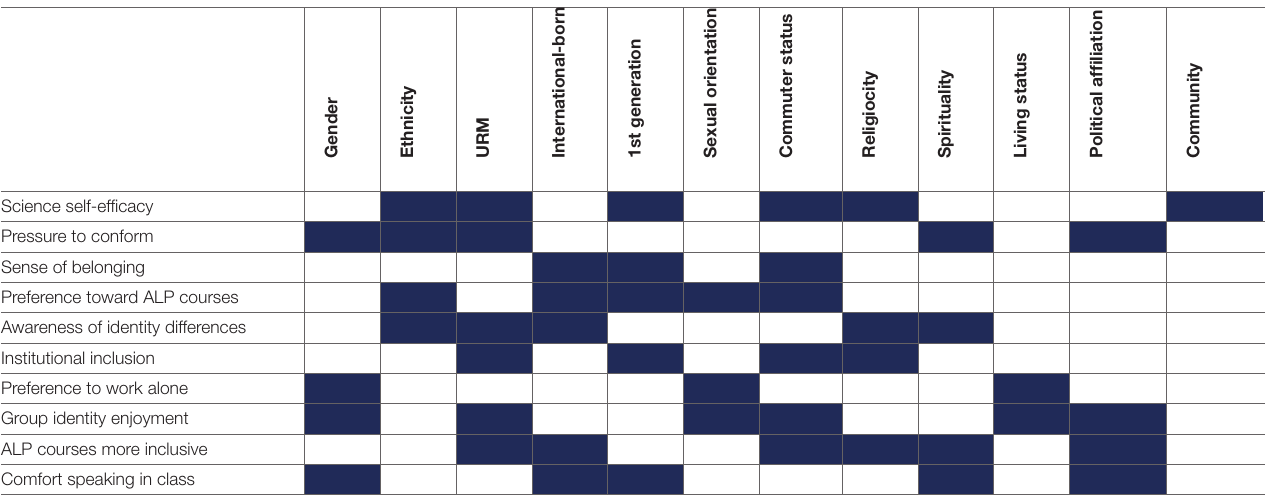
TABLE 3 | Predictors retained (blue) within multi-model fitting of 10 multiple regression models that predicted outcome measures that were within 4 AIC score